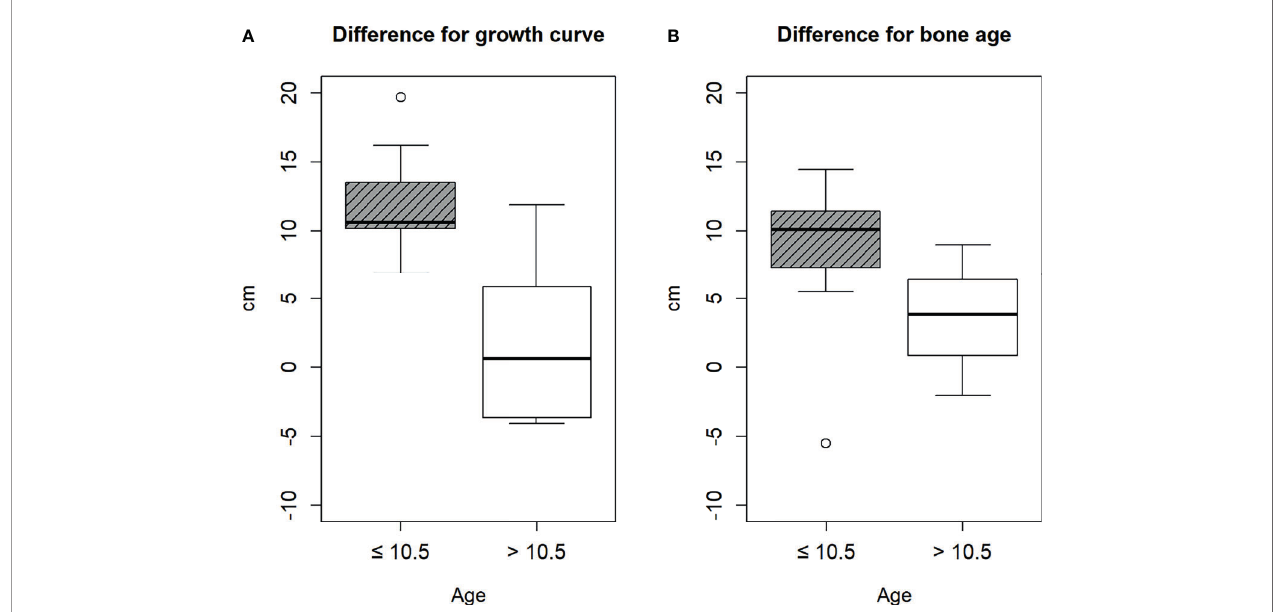
FIGURE 1 | Difference between the estimated height and fi nal height. (A) by growth curve, (B) by bone